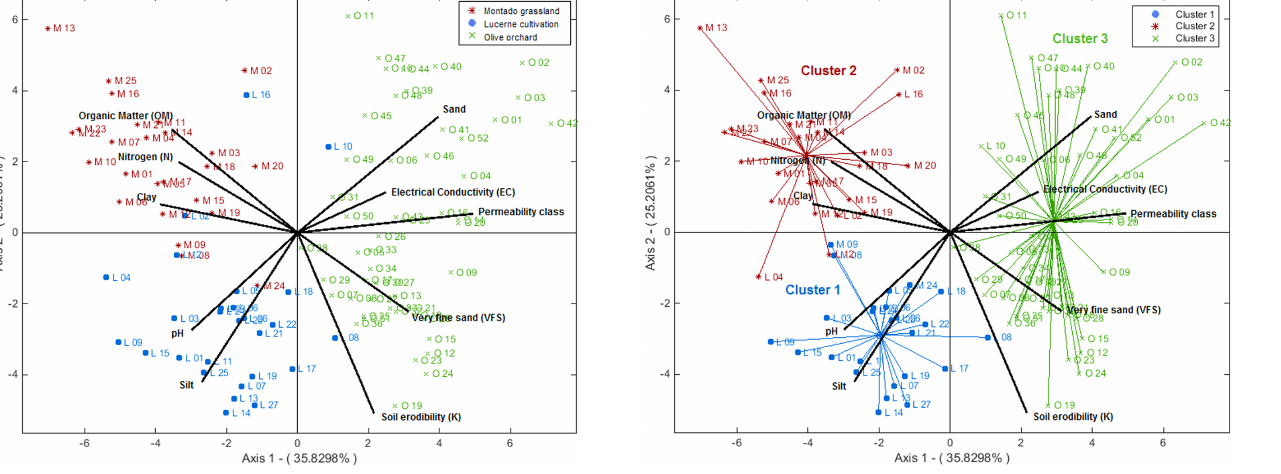
Figure 4. The HJ-Biplot representation matrix of soil samples and studied variables.